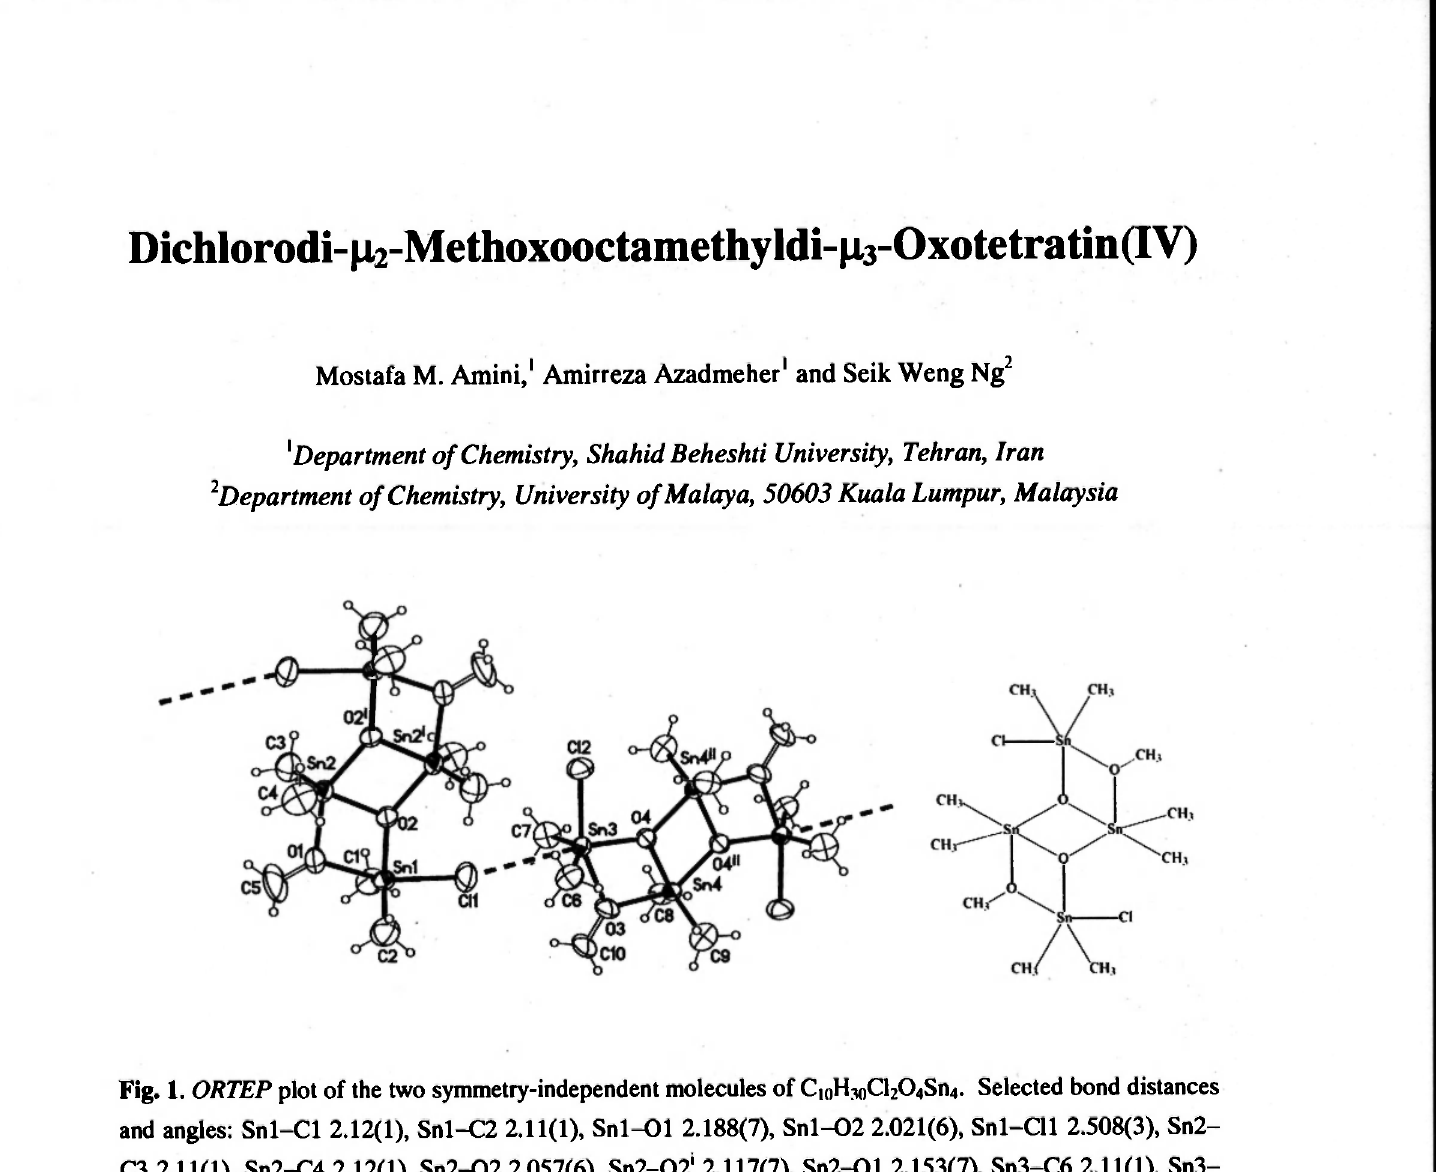
Fig. 1. ORTEP plot of the two symmetry-independent molecules of CmH^C^Sru. Selected bond distances and angles: Snl-Cl 2.12(1), Snl-C2 2.11(1), Snl-Ol 2.188(7), Snl-02 2.021(6), Snl-CU 2.508(3), Sn2-